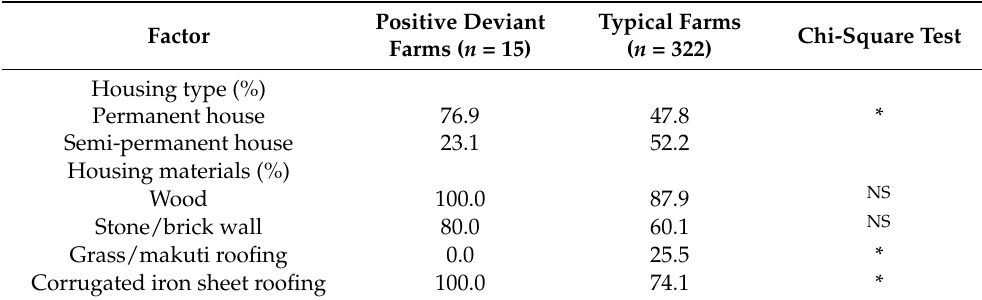
Table 3. Animal distribution frequency (percentage) by breeds in positive deviant and typical farms under stressful environments. Factor Level